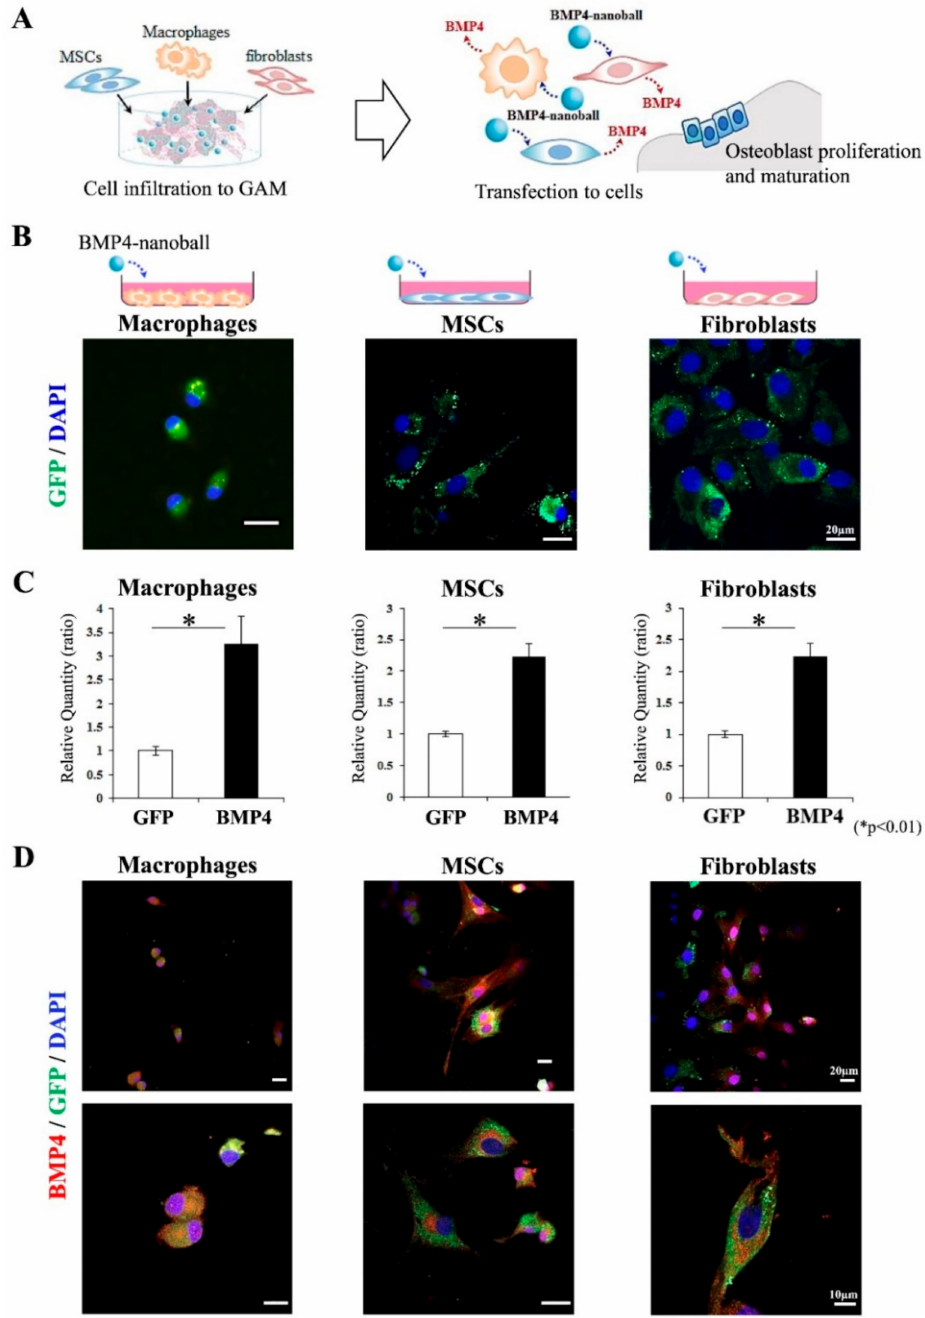
Figure 2. Biological activity of BMP4-nanoballs in vitro. ( A ) Schematic diagram of bone formation by infiltration of macrophages, MSCs, and fibroblasts into transplanted GAMs. ( B ) GFP expression in macrophages, MSCs, and fibroblasts at 2 h after in vitro transfection of GFP-nanoballs. Scale bar is 20 µ m. ( C ) BMP4 mRNA expression in each type of cell at 48 h after transfection of GFP-nanoballs and BMP4-nanoballs ( n = 3, * p < 0.01). ( D ) BMP4 production in each type of cell at 48 h post-transfection of BMP4-nanoballs. Scale bars are 20 µ m (upper panels) and 10 µ m (lower